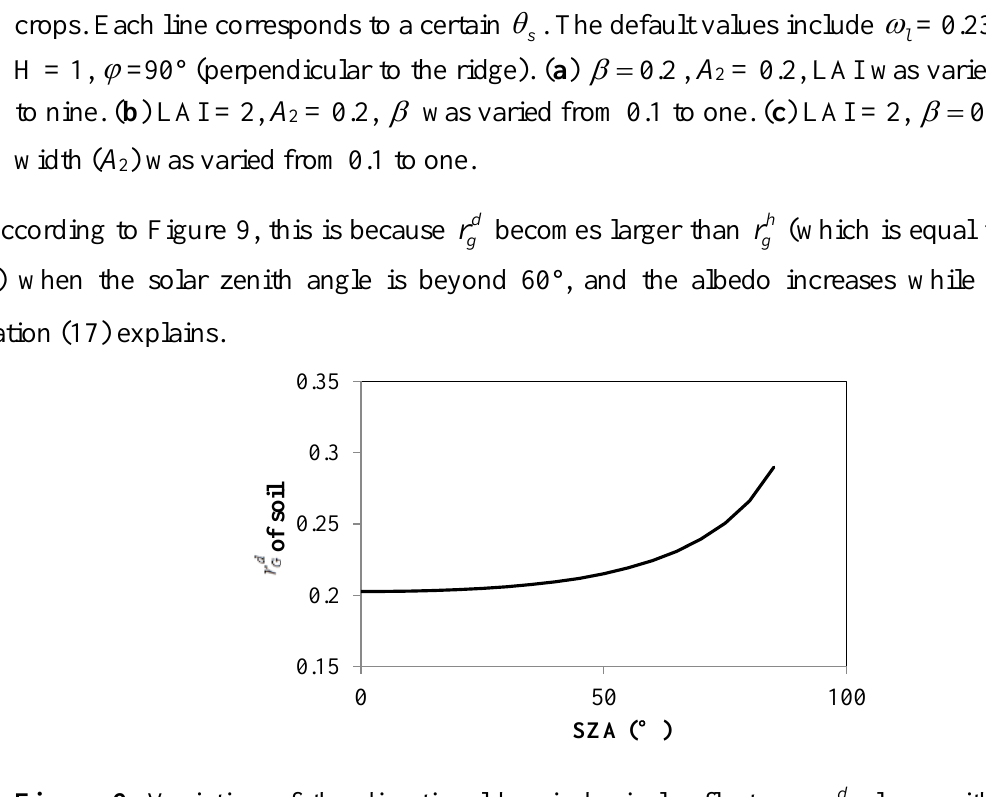
r along with the solar g